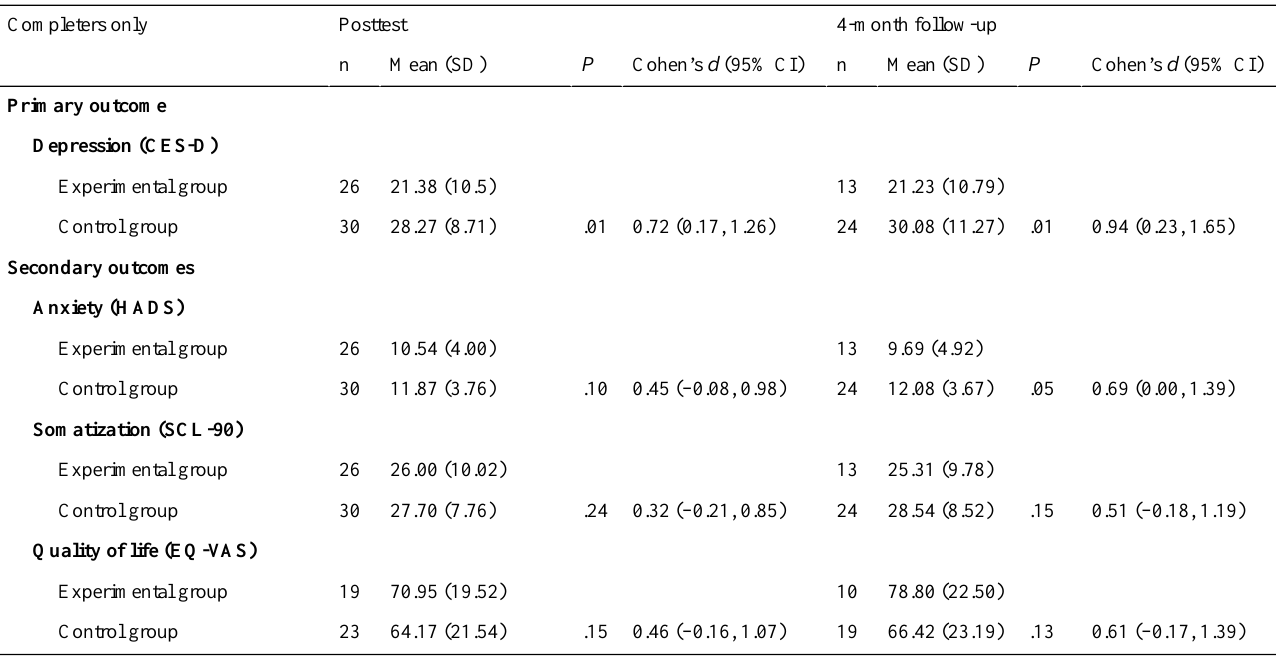
Table 5. Study outcomes of participants at posttest and follow-up including follow-up between-group effect size (Cohen’s d ): completers only (n=56).